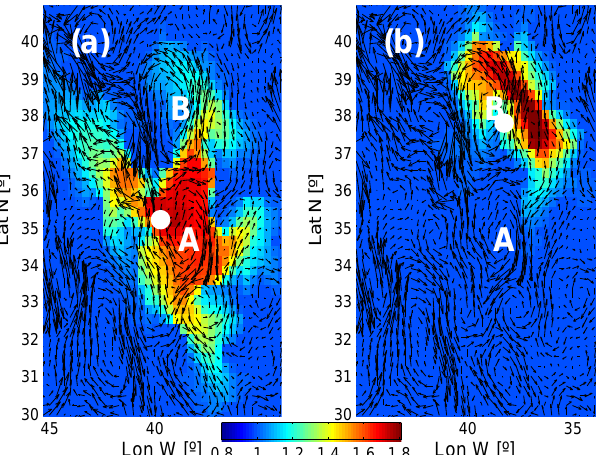
Fig. 8. Phytoplankton concentration P/P 0 for two different patches in the North Atlantic ocean after 30days of simulation initiated at the white dot, respectively. Letters A and B mark the centres of eddies of similar